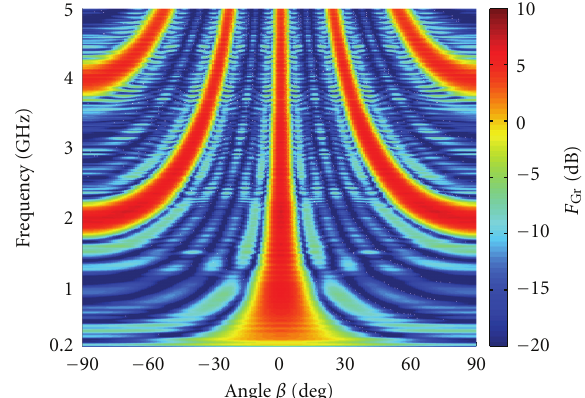
Figure 14: Gain pattern of synthesised antenna array.